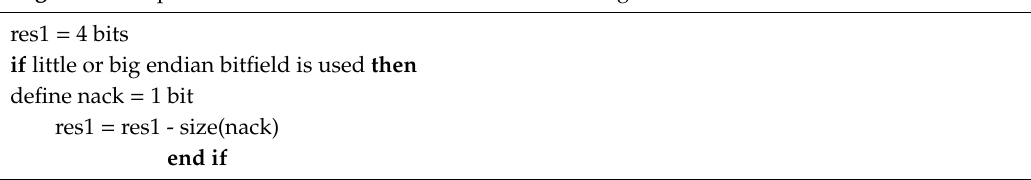
Algorithm 1 tcphdr structure modifications for the NACK flag insertion